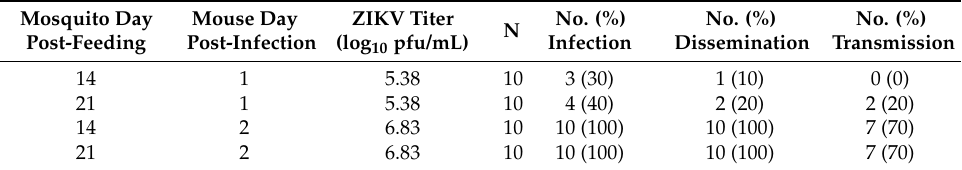
Table 2. Infection, dissemination, and transmission of ZIKV in Aedes aegypti . Mosquito Day Post-Feeding